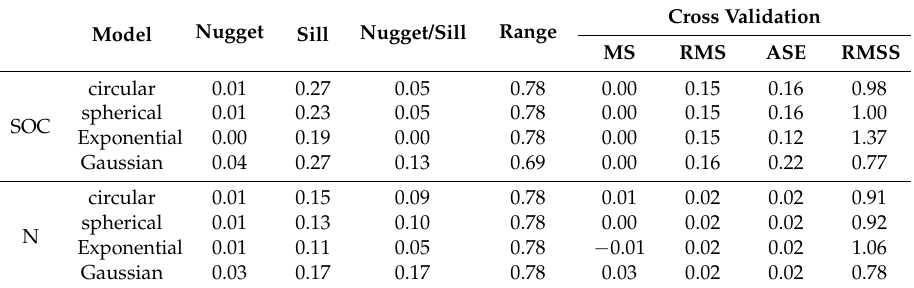
Table 4. Parameters of different Kriging models of organic carbon and nitrogen.